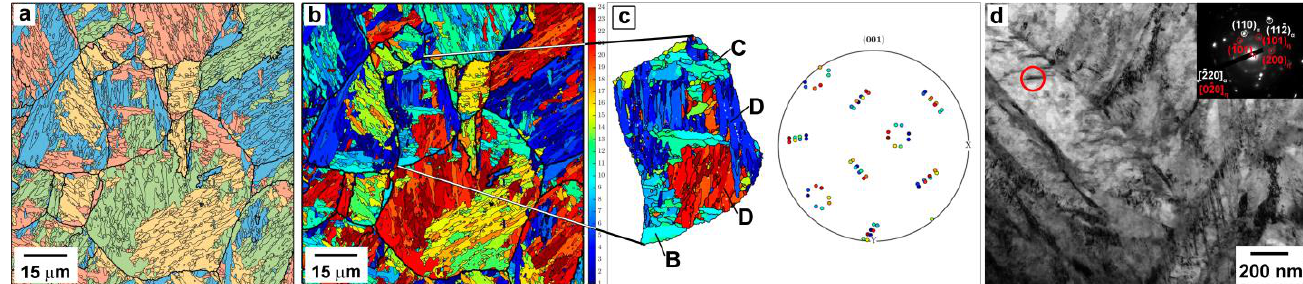
Figure 3. EBSD analysis of the as-quenched steel: ( a ) Misorientation map showing HABs of the reconstructed austenite grains and packets; ( b ) misorientation map of reconstructed PAGs with their boundaries in black; ( c ) identification of packets in a PAG indicated as A in ( a ) and {001} pole figure showings (0 0 1) [1 0 0] orientations that maintain the K–S orientation relationship; identification of packets in PAGs; ( d ) TEM observation of the steel subjected to water quenching and tempering at 280 °C, with the insert indicating the presence of transition η - carbide.